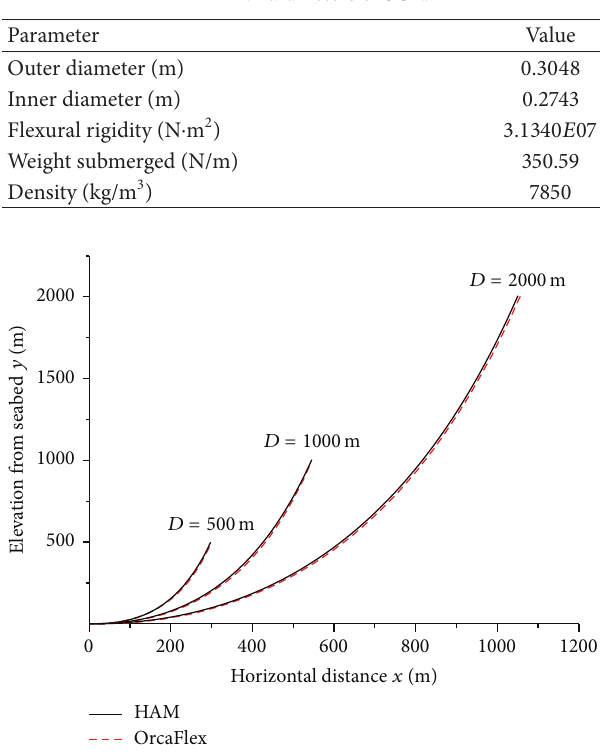
Figure 7: Configuration results comparison between HAM and OrcaFlex in different water depth.